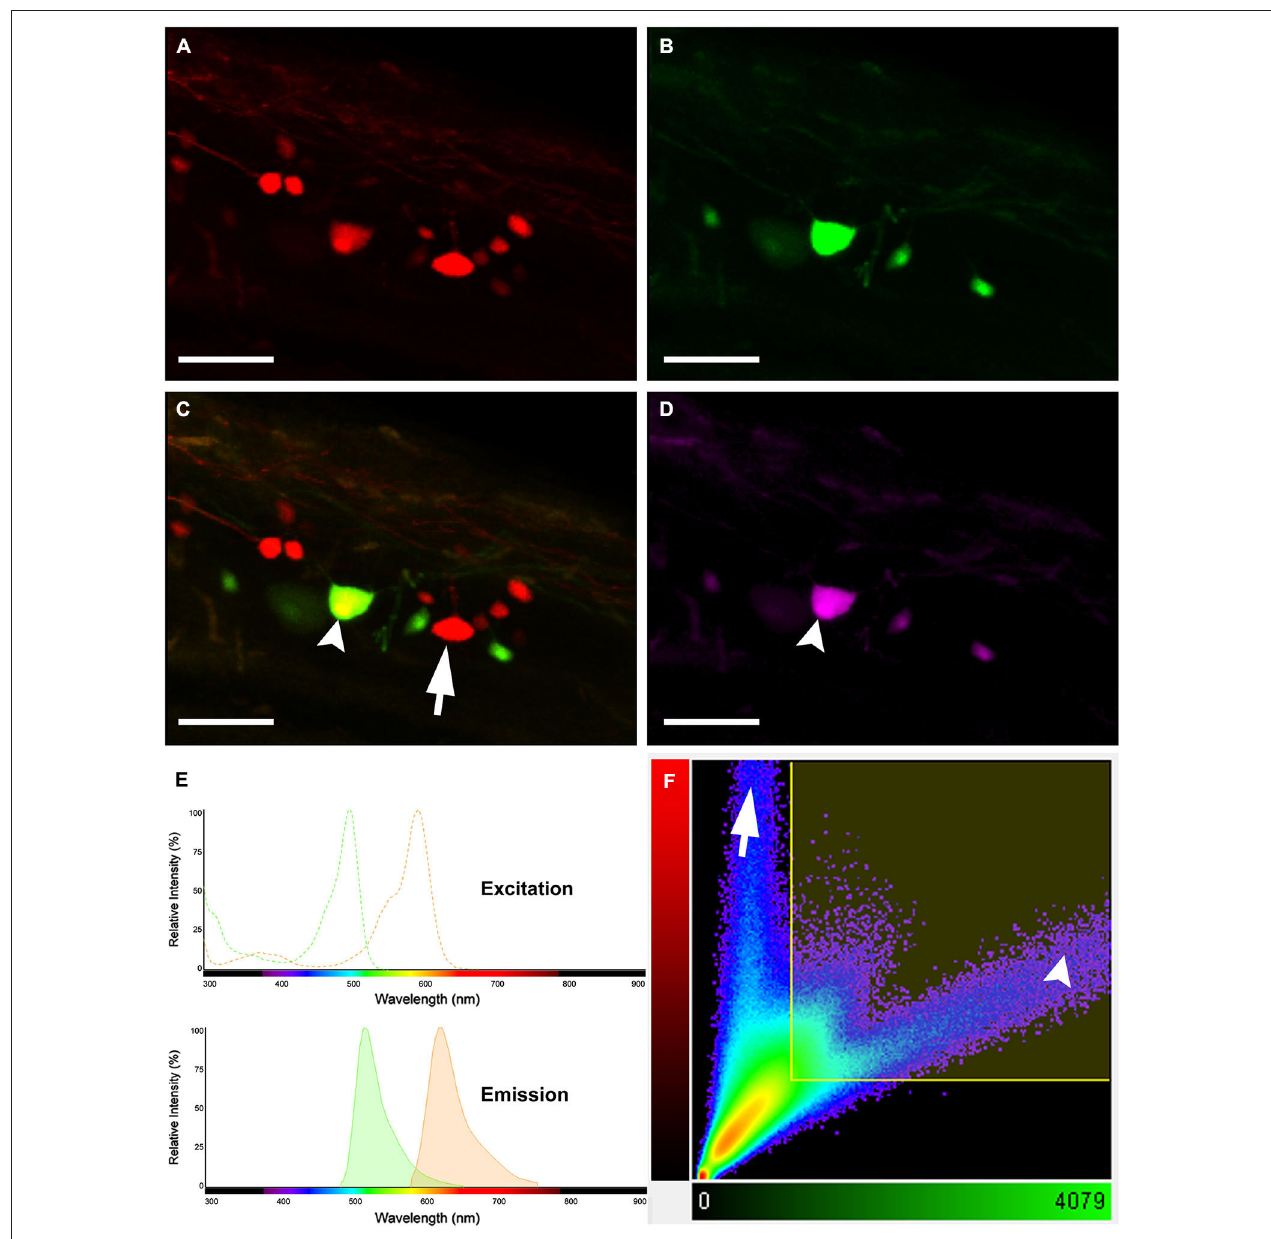
co-localization channel (D) , that AFB-594 retrogradely labeling diffuse to neighbor cells (arrow) in contrast to Mini-Emerald (arrow head). (E) Excitation and Emission spectra were carefully selected to avoid cross-talk and bleed-through of the dyes. Finally, F shows the co-localization scatter plot, the selected region was tresholded based on the average intensity of the somas (900) on each channel. Pearson’s coefficient in the co-localized volume for this analysis was 0.5172. Calibration bar equals 50 µ